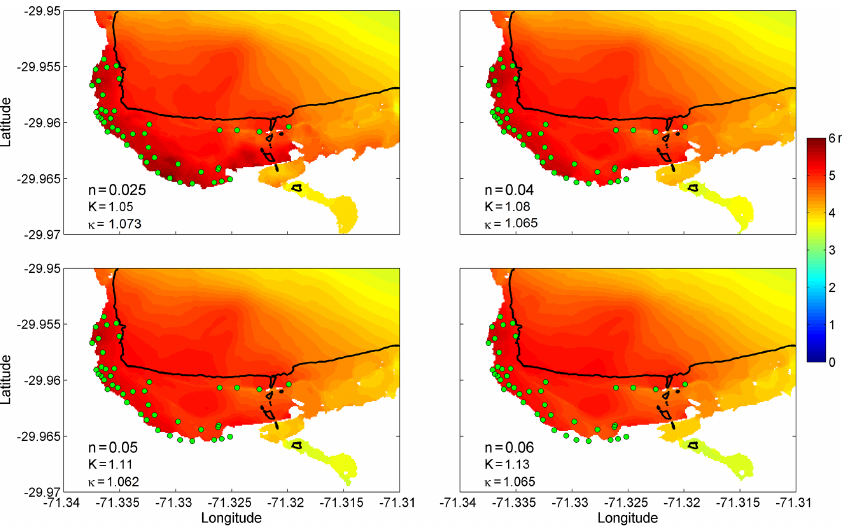
Figure 6. Tsunami inundation heights obtained with the modified Li et al. (2016) source model and four different Manning coefficients, n = 0 . 025, 0.04, 0.05 and 0.06. The parameters of root mean square error, K and κ area are also